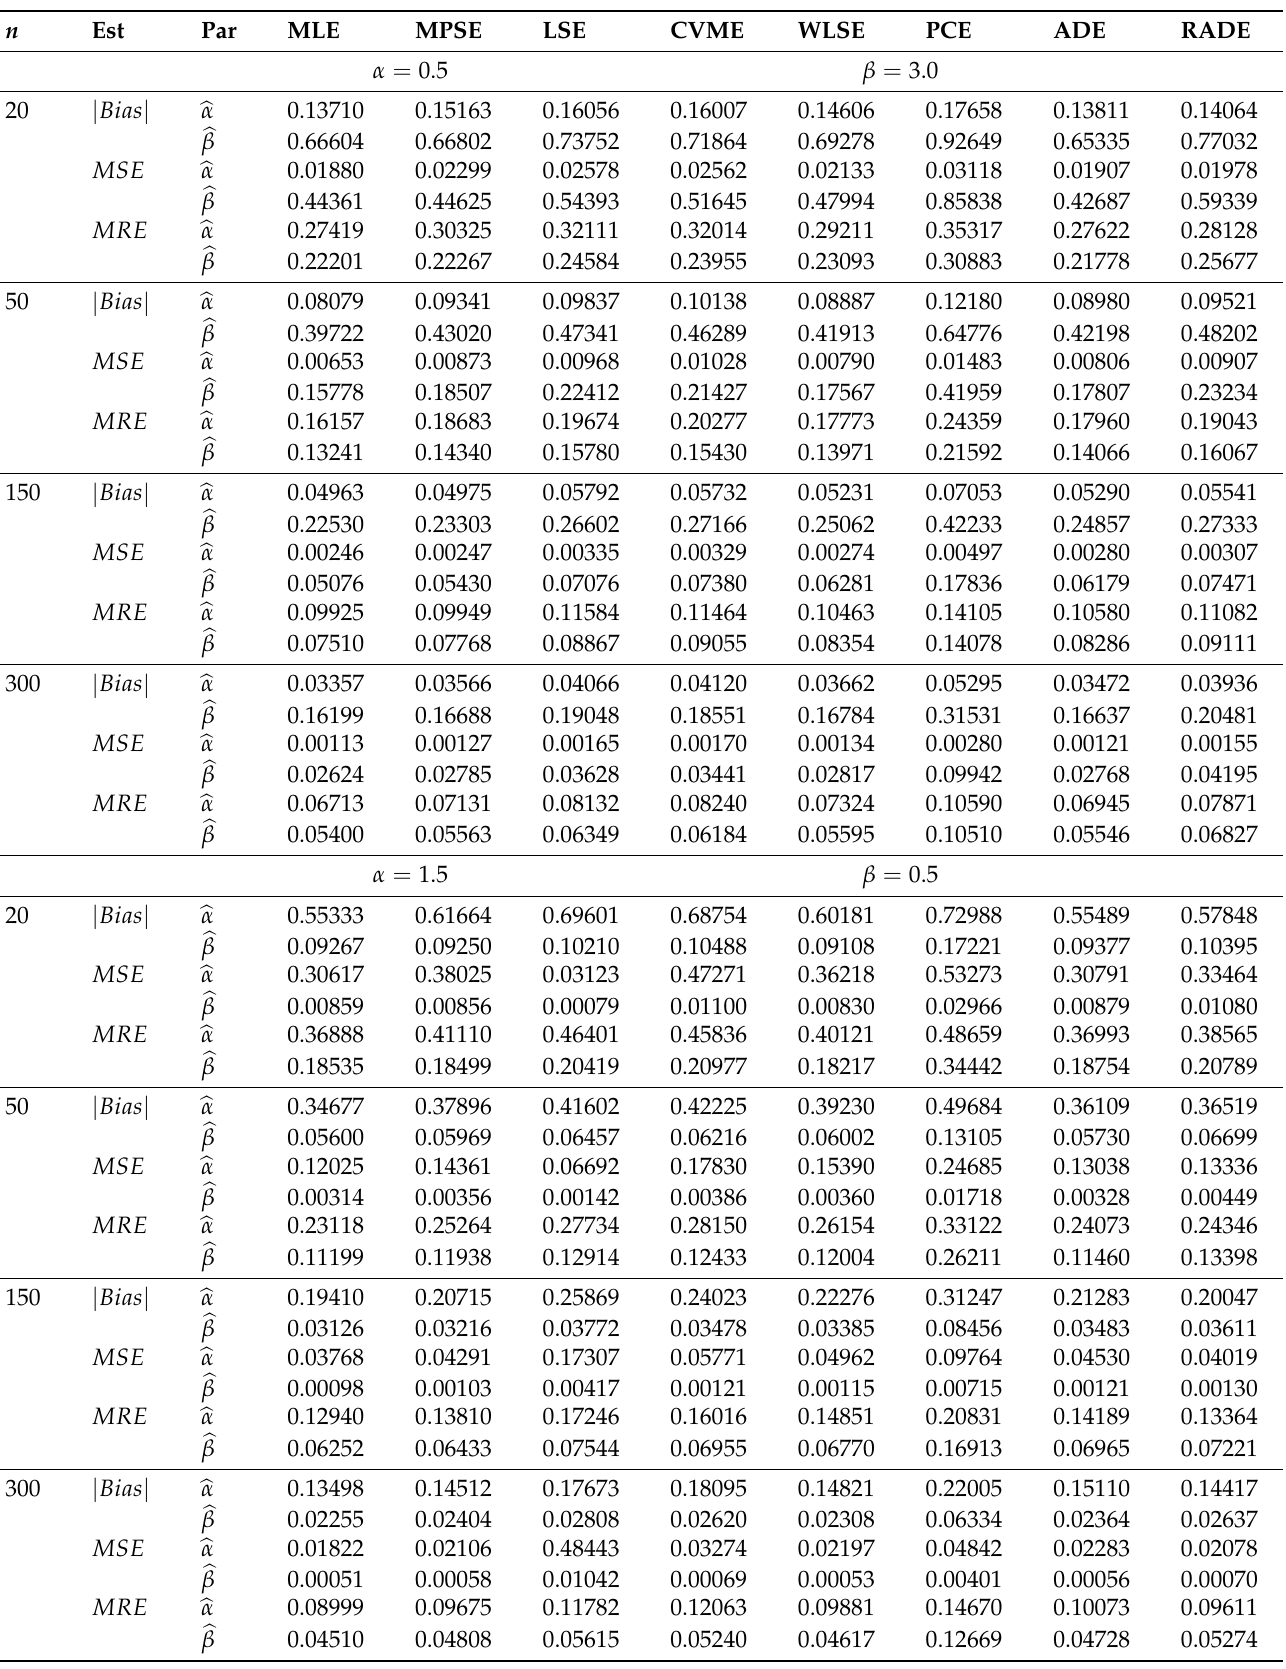
Table 4. Simulation results of the eight estimation methods for α = 0.5,1.5 and β =